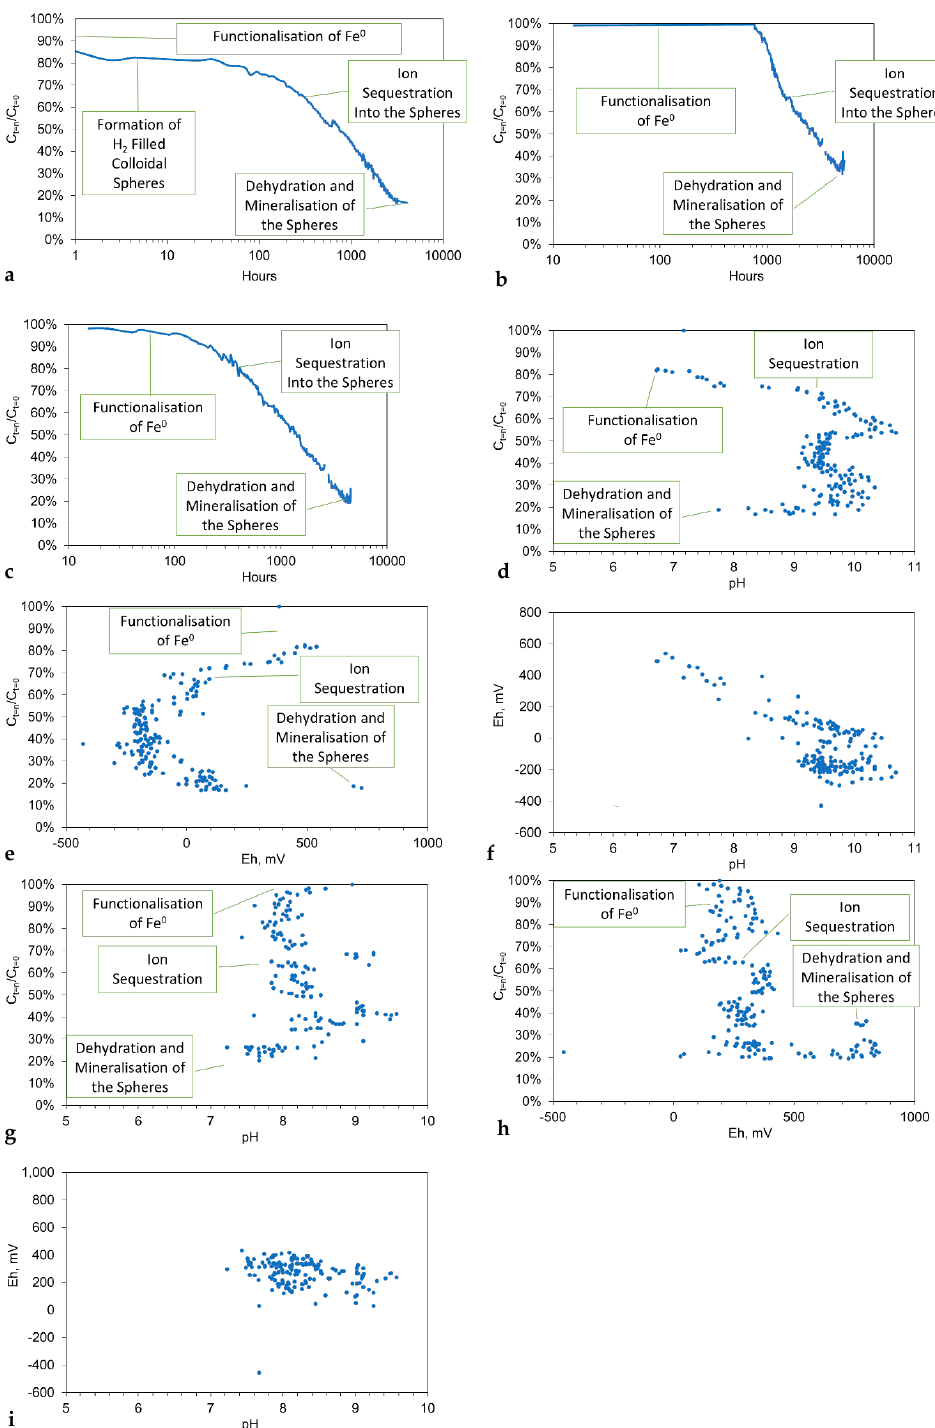
Figure 8. Examples of n-Fe 0 (50 nm, 25 g L − 1 Fe 3 O 4 coated) desalination ( C t = n / C t= 0 ) versus